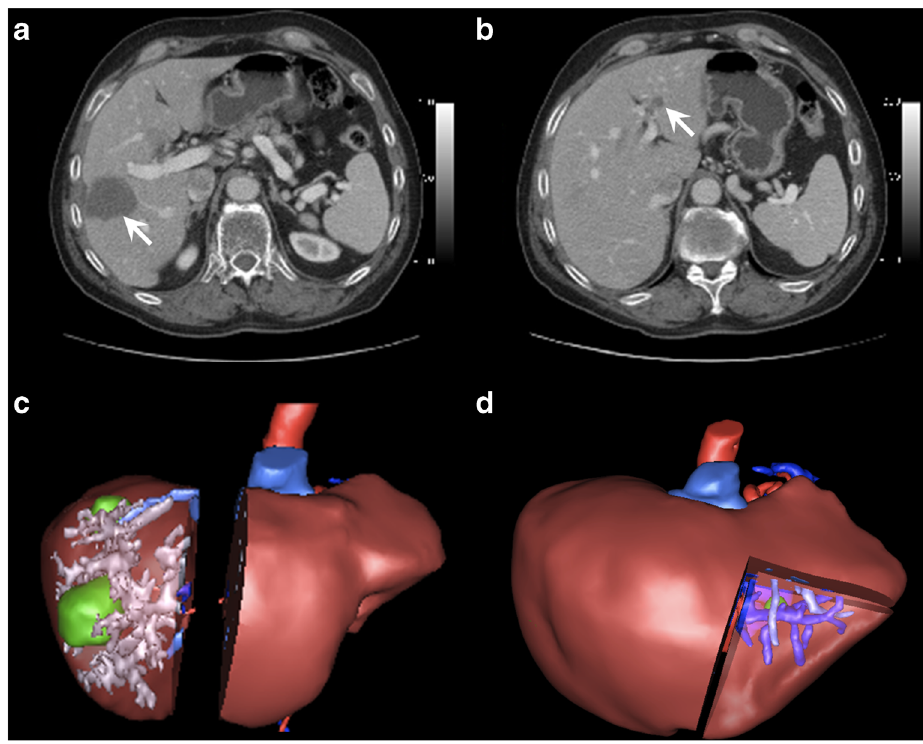
Fig. 15 Liver subsegmentation according to vascular anatomy. Axial enhanced CT showing the segmented a hepatic arterial, b portal venous and c hepatic venous structures. Three-dimensional rendering of the same